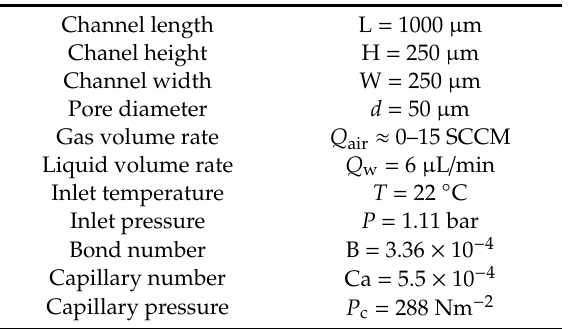
Table 1. Experimental conditions and physical parameters.